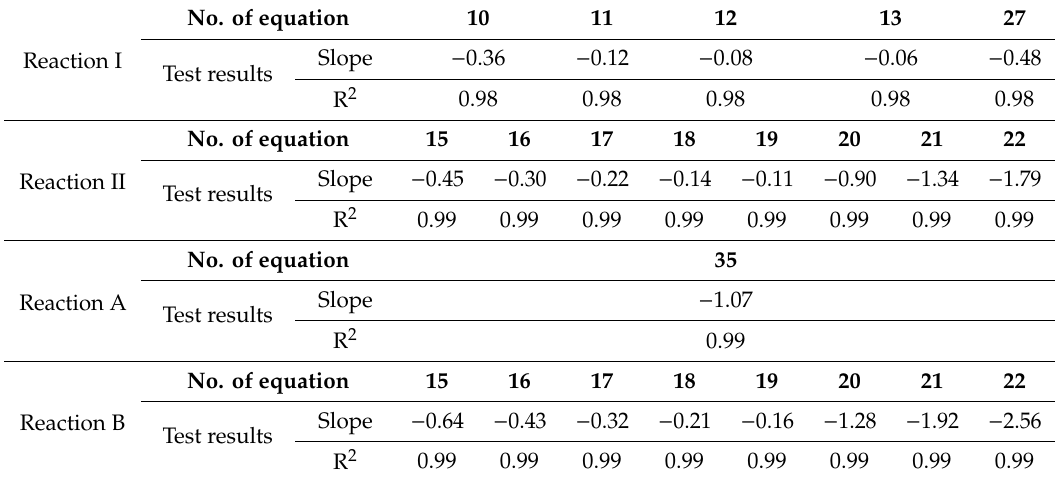
Figure 5. ( a ) Comparison of standard y ( α ) based on the equations listed in Table 3 with y ( α ) based on Reaction I; ( b ) comparison of standard y ( α ) based on the equations listed in Table 3 with y ( α ) based on Reaction II; ( c ) comparison of standard y ( α ) based on the equations listed in Table 3 with y ( α ) based on Reaction A; ( d ) comparison of standard y ( α ) based on the equations listed in Table 3 with y ( α ) based on Reaction B. Table 3. The calculation results by Malek method based on Figure 5 and the test